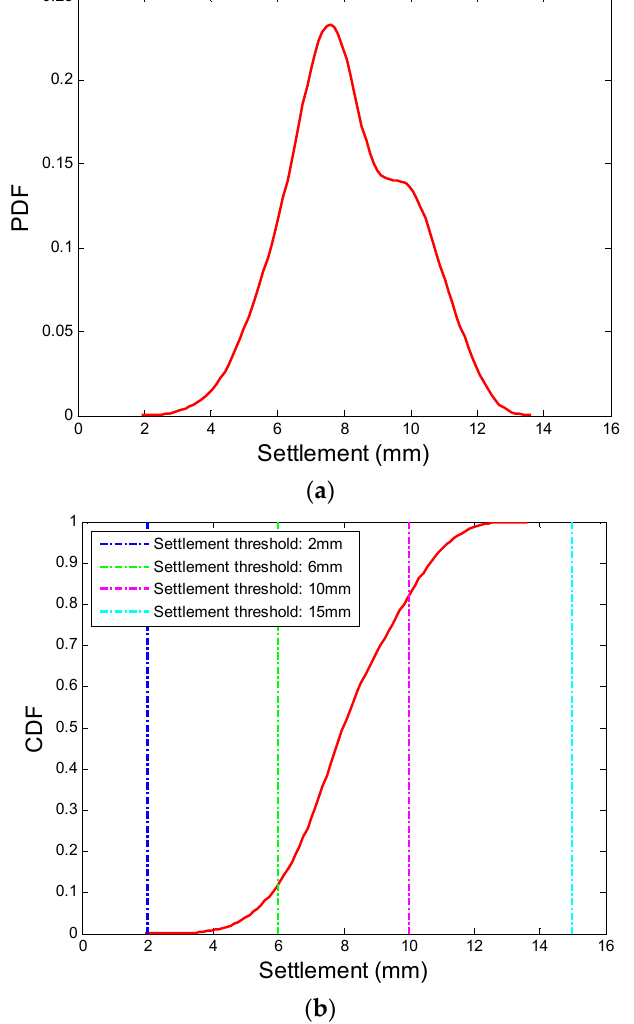
Figure 15. ( a ) Maximum settlement PDF and ( b ) maximum settlement CDF at the RC pile head.